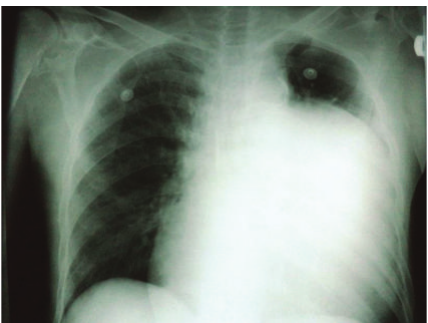
Figure 1: Patient’s chest radiography shows cardiothoracic enlargement with homogenous opacity in left hemithorax. Space occupying, cystic lesions, and vascular aneurysm are differential diagnosis of this condition.